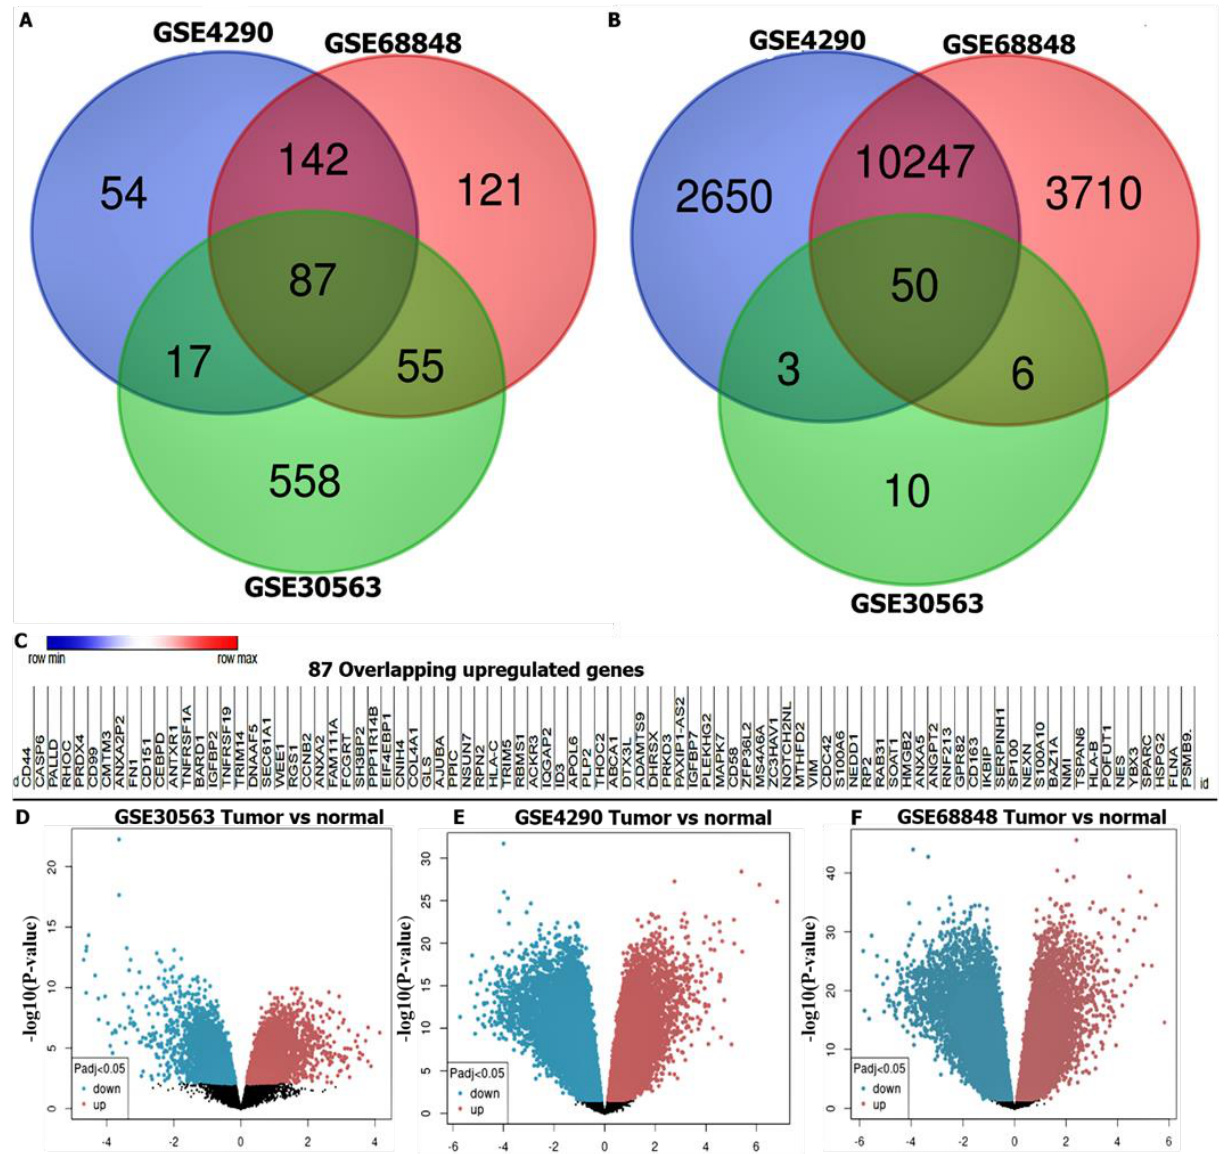
Figure 2. Differentially-expressed genes (DEGs) in glioblastoma multiforme (GBM) extracted from the GSE4290, GSE68846, and GSE30563 microarray datasets. ( A ) Venn diagram of 87 selected overexpressed overlapping DEGs. ( B ) Venn diagram of 50 selected downregulated overlapping DEGs. ( C ) is the heatmap of overexpressed overlapping genes. ( D – F ) Volcano plots of DEGs from the GSE4290, GSE68848 and GSE30563 datasets with red and blue dots respectively representing upregulated and downregulated genes (at p < 0.05).